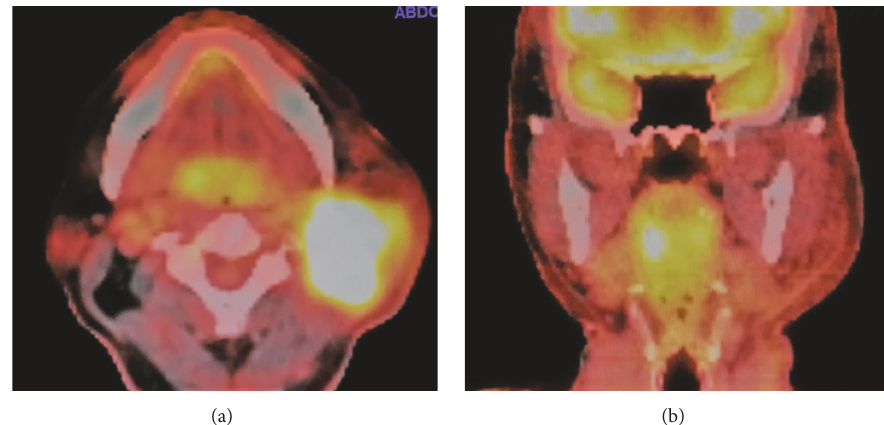
Figure 3: PET/CT scan ((a) axial view; (b) coronal view). A PET/CT showed a high accumulation of fluorodeoxyglucose (FDG) to the left neck mass, and there was a slight laterality of FDG accumulation in the tonsils with the right-side predominance. The tonsillar uptake of the FDG was within the physiological range, which was not conclusive for the diagnosis of the tonsillar primary lesion.